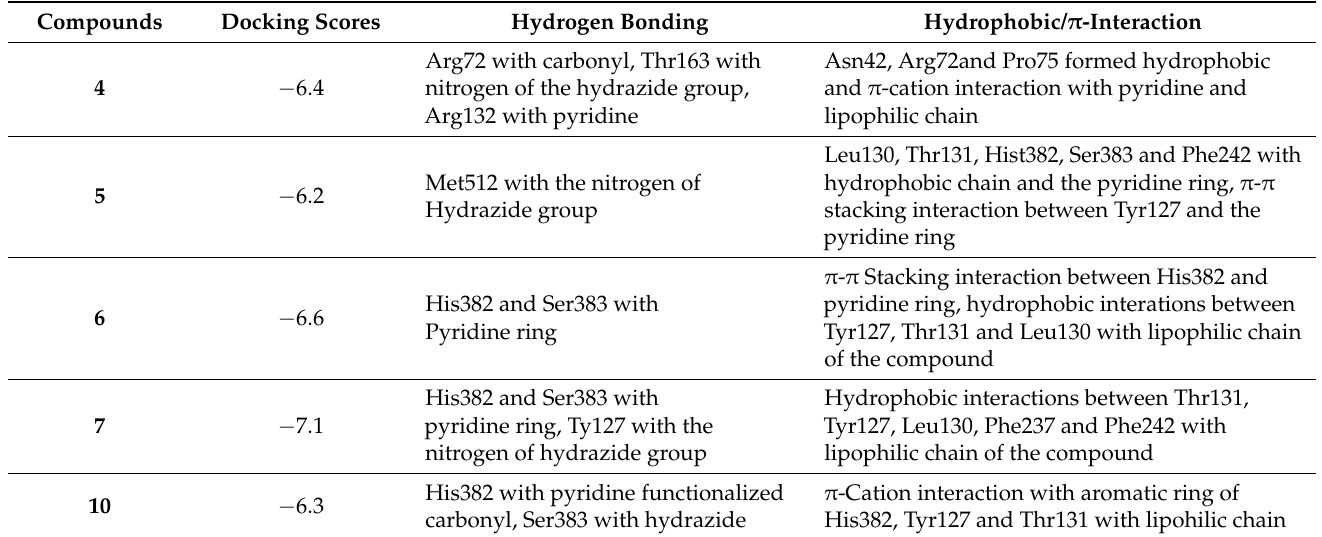
Table 3. Docking scores and binding interaction of pyridine-containing lipophilic hydrazides with the active site residues of antibacterial and antifungal target